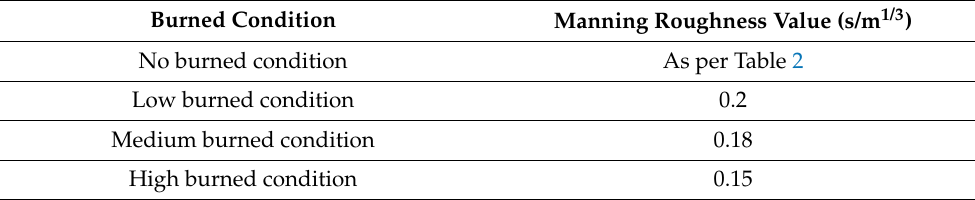
Table 4. Manning roughness value for different burned conditions.